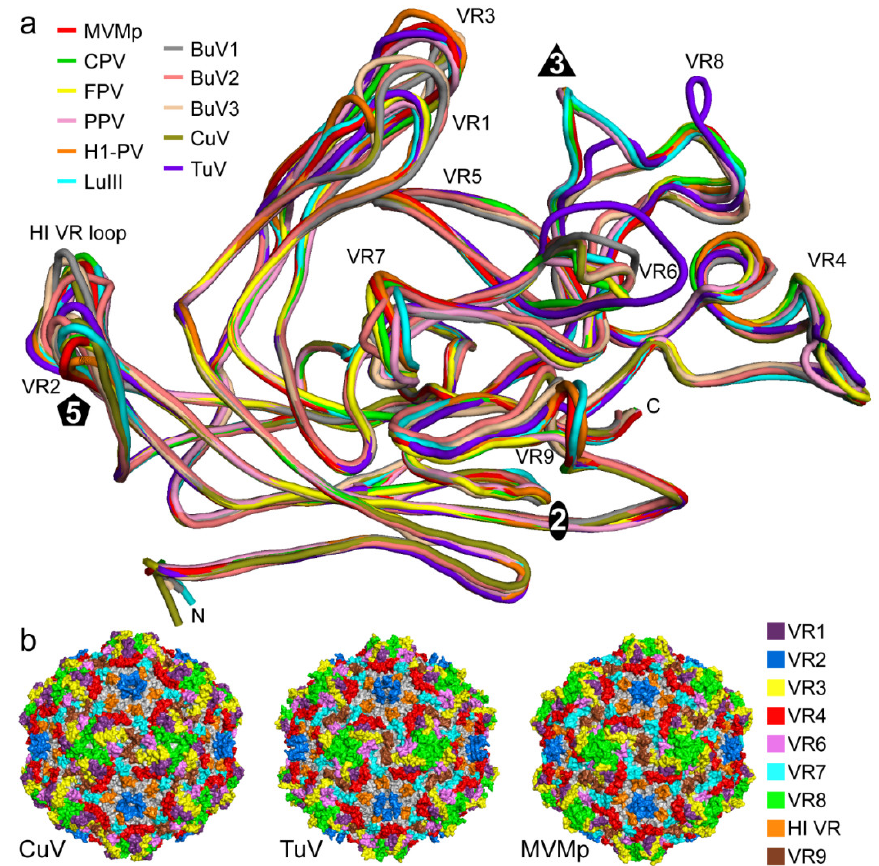
Figure 4. Structural comparison of protoparvoviruses. ( a ) The superposed VP structures for all available members are shown as coil diagrams: MVMp (red), CPV (green), FPV (yellow), PPV (pink), H1-PV (orange), LuIII (cyan), BuV1 (gray), BuV2 (salmon), BuV3 (tan), CuV (olive), and TuV (purpleblue). The N- and C-terminus, the approximate icosahedral 2-, 3-, and 5-fold axis, and the VRs are indicated. ( b ) Surface representations of the CuV, TuV, and MVMp capsids. The new VR assignment is used and colored as indicated in the legend on the right. This figure was generated using PyMol [45].